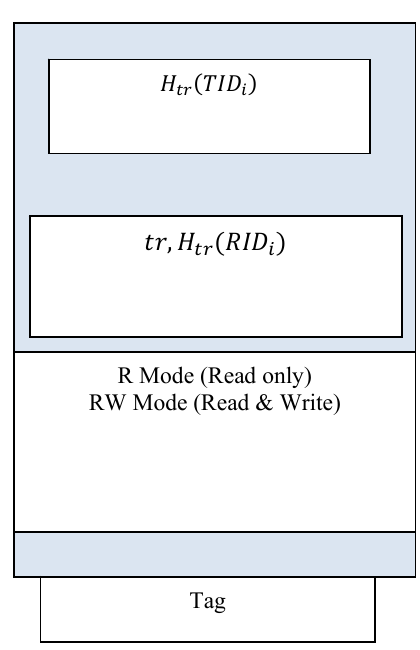
Figure 1: Tags setup and